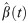
Parameter setting based on Example 2 and τ = 0.5.The solid curves true function β(t); dotted line estimated function β^(t).